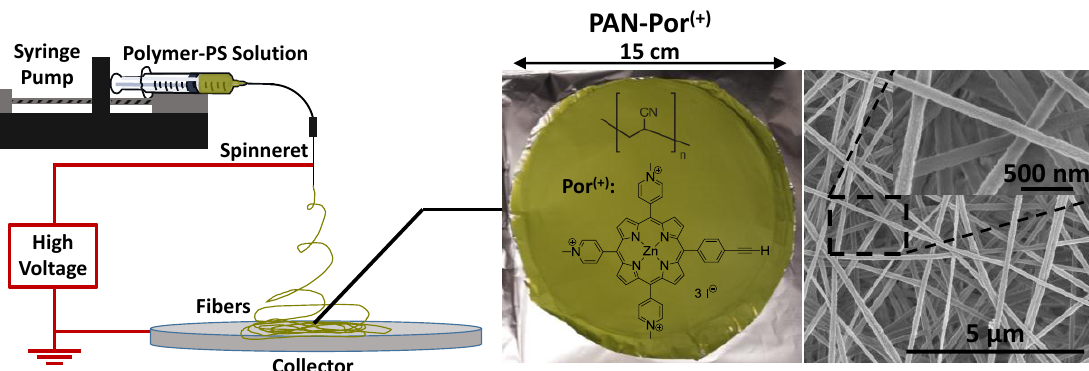
Figure 1. Electrospinning schematic ( left ), PAN-Por (+) ( middle ), and scanning electron microscopy (SEM) images ( right ).